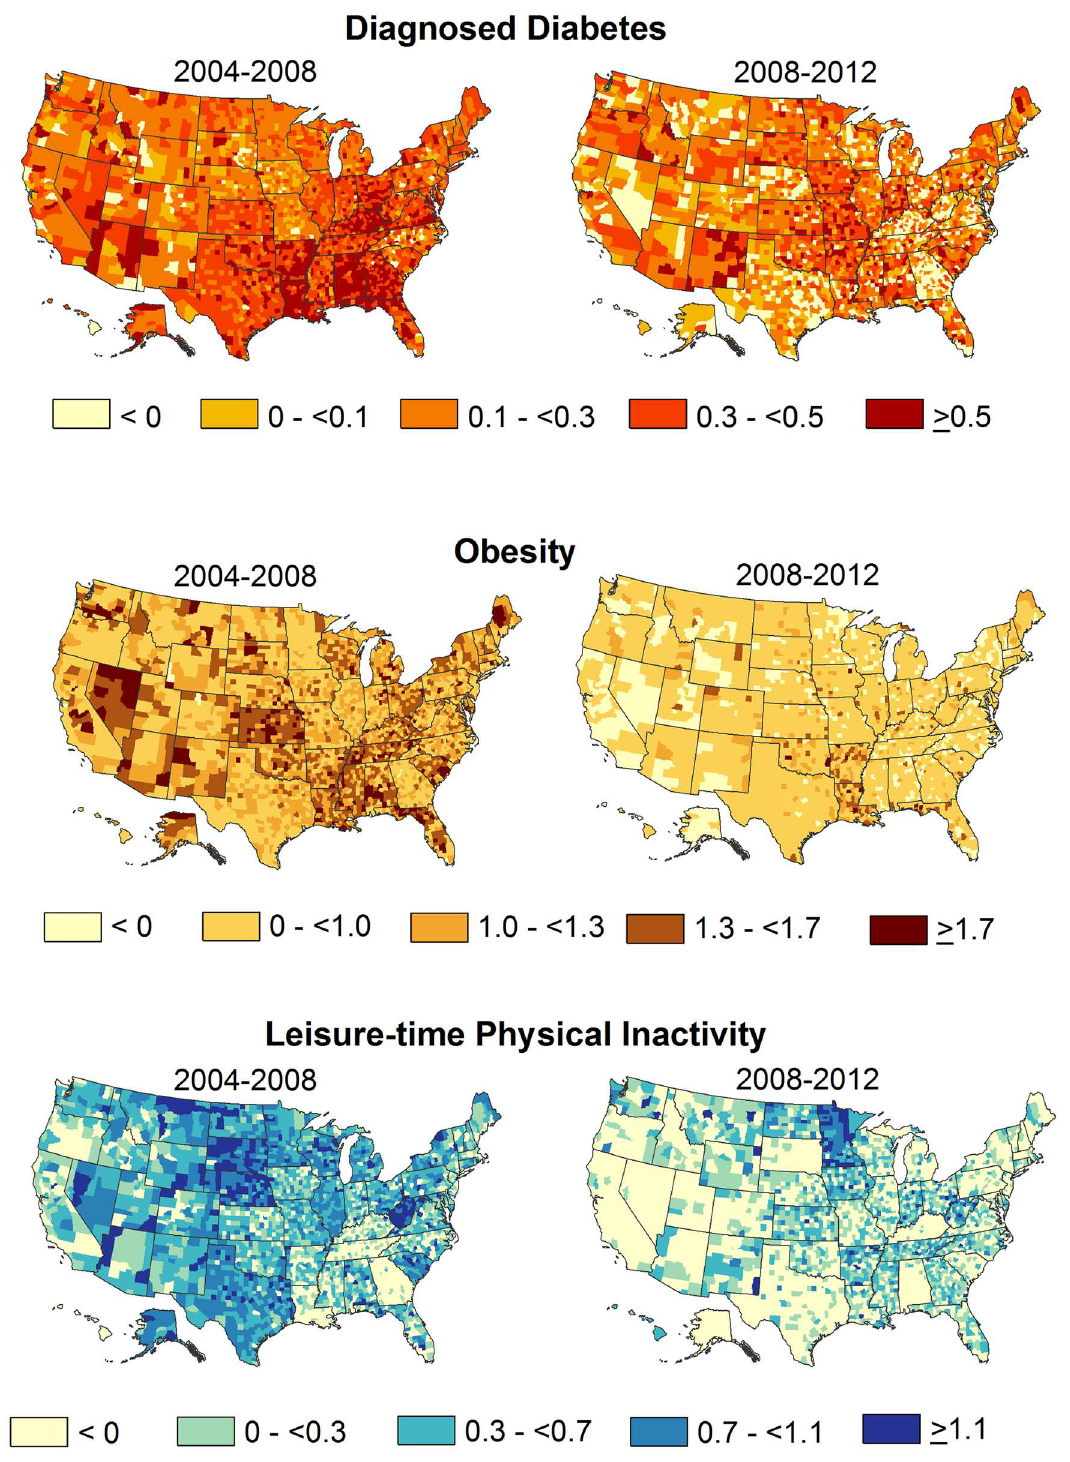
Fig 1. AverageAnnual Percentage Point Change (AAPC) in diagnosed diabetes, obesity, and physical inactivity prevalence, US counties, 2004–2008and 2008–2012.